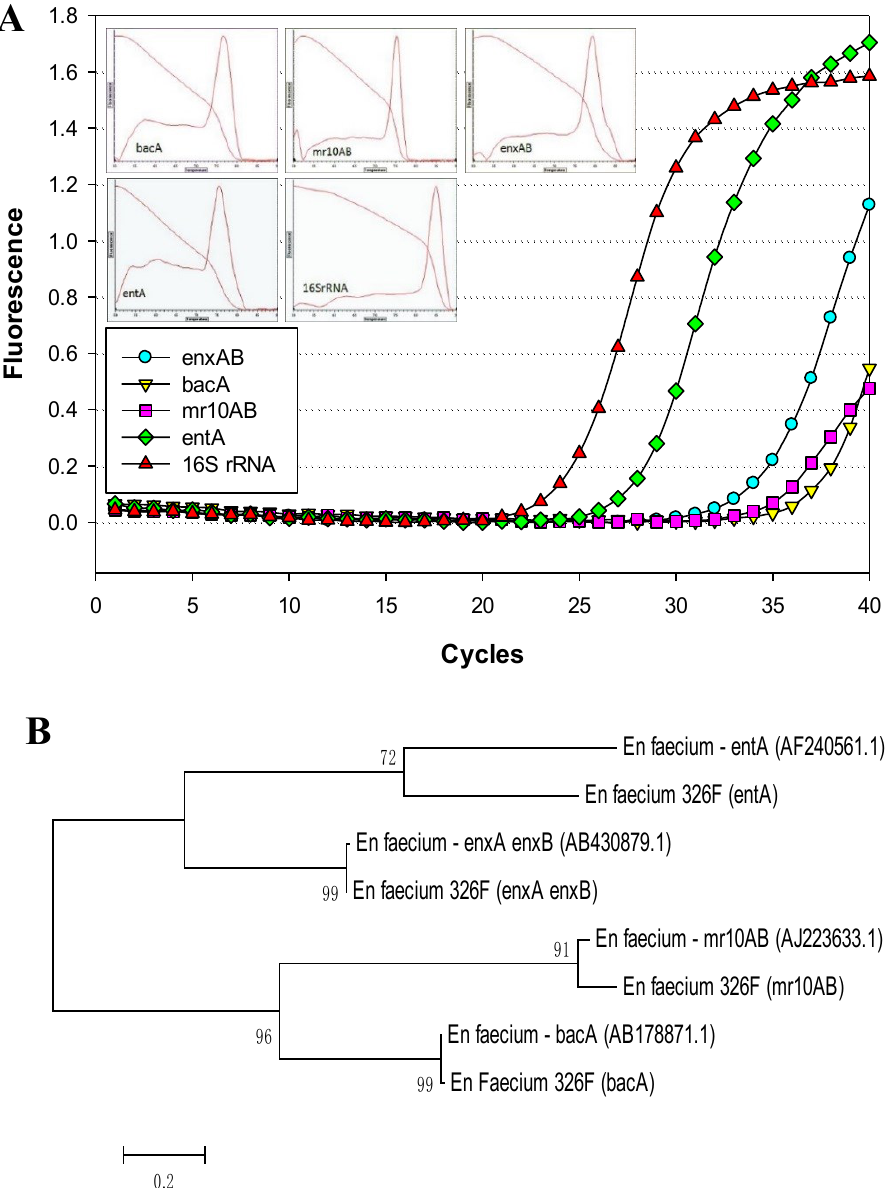
Figure 2. Real-time PCR and dendrogram of sequence alignment of four bacteriocins from En. faecium 326F. Panel A , real-time PCR amplification of En. faecium 326F using a